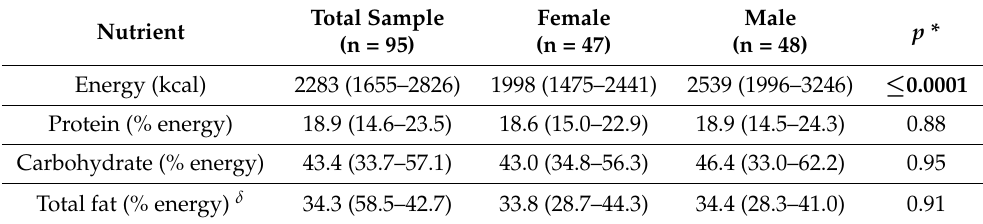
Table 2. Energy and dietary macronutrient intakes of female and male endurance